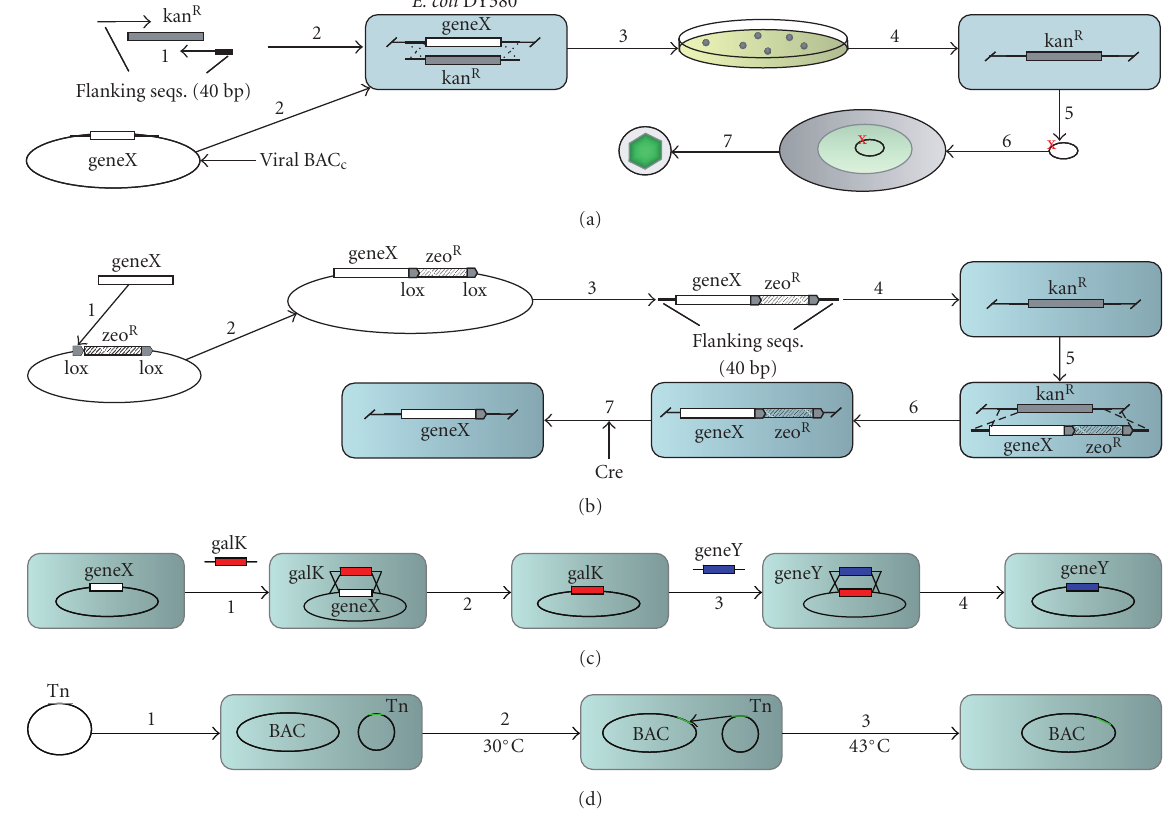
Figure 3: BAC mutagenesis techniques. (a) generation of a deletion mutant via homologous recombination. (1) Amplification of the kan R expression cassette by PCR using a primer pair adding 40-bp (or longer) homologies flanking ORFX. (2) Viral BAC DNA is introduced into DY380 by electroporation. (3) Homologous recombination between upstream and downstream homologies of Gene X replaces Gene X with a selectable marker (the Kan R cassette), creating the Gene X-deletion viral BAC. (4) The recombinants are selected based upon their ability to grown on LB agar plates containing kanamycin. (5) The viral BAC DNA is isolated, and the deletion of Gene X is confirmed by PCR analysis. The integrity of the viral genome (after homologous recombination) is examined by restriction enzyme digestion. (6) Purified BAC DNA is transfected into a human cell line. (7) Viral proteins are expressed, and a functional virus is created. B. Generation of Rescue